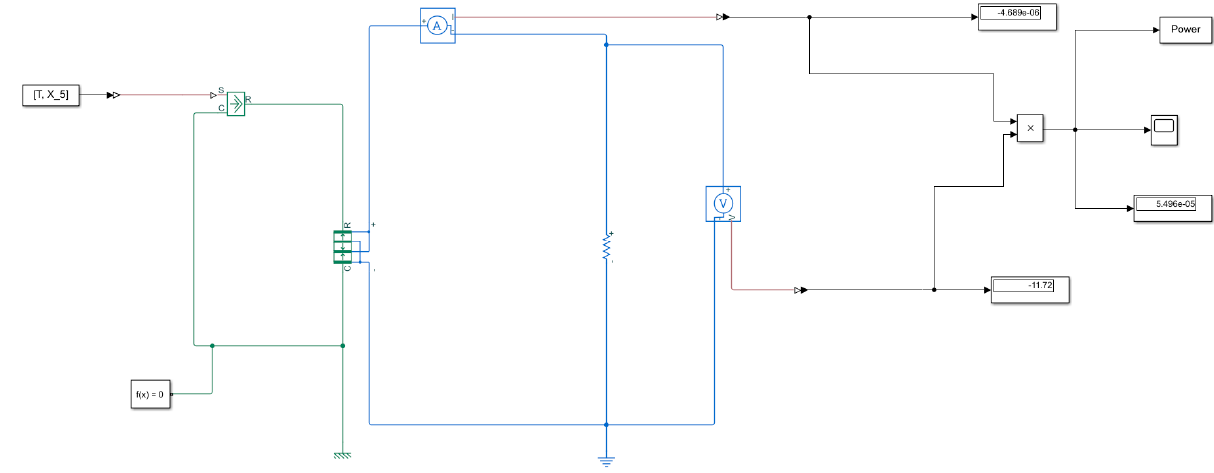
Figure 6. Mechanical–electrical conversion model of vibrations into electrical energy.